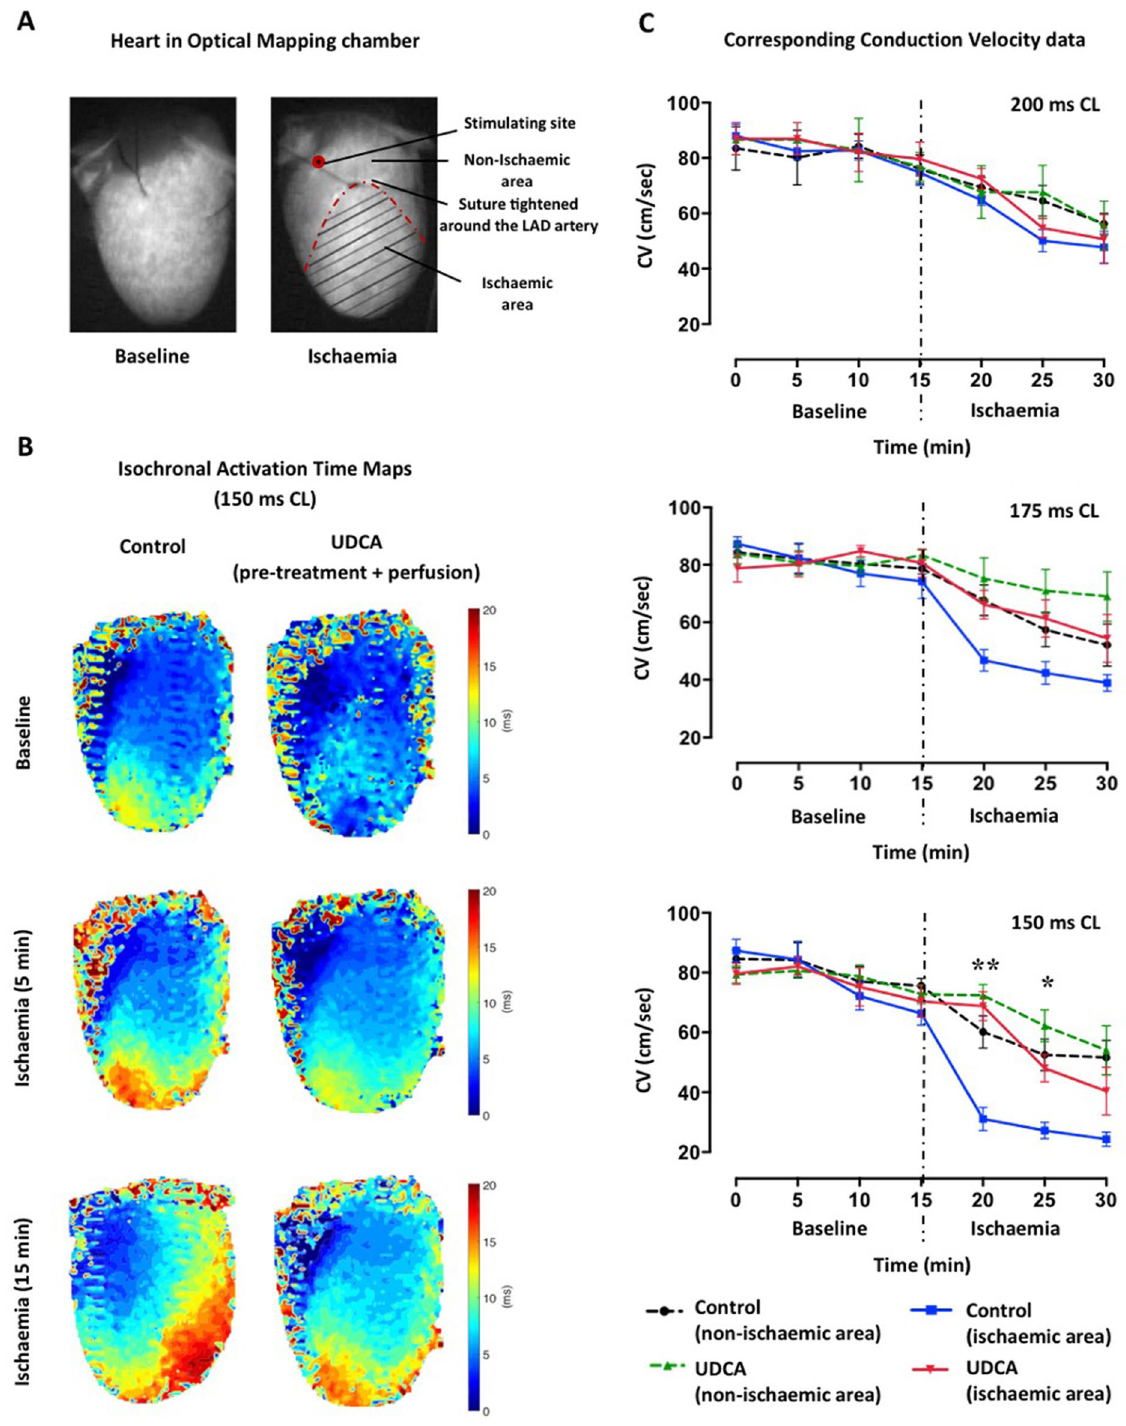
Figure 3. Summary of data on whole heart optical mapping. ( A ) Heart chamber set up at baseline and during myocardial ischaemia. ( B ) Representative isochronal activation time maps at baseline and during ischaemia of hearts pre-treated and perfused with UDCA, compared to control hearts when pacing at 150 ms cycle length (CL) (blue is early activation and red is late activation). ( C ) Corresponding conduction velocity (CV) data from non-ischaemic versus ischaemic areas, during sequential pacing at different CLs, showing that prolonged UDCA administration attenuates ischaemia-induced CV slowing in the early stage when pacing at 150 ms CL. Data from control (n = 6) and 150 mg/kg/daily + 1 μM UDCA (n = 5) hearts, ** , *CV from UDCA pre-treated and perfused hearts significantly different from control within ischaemic areas at 5 and 10 min ischaemia (** p = 0.0016, * p = 0.0255, by 2-way ANOVA (multiple comparisons) with post-hoc